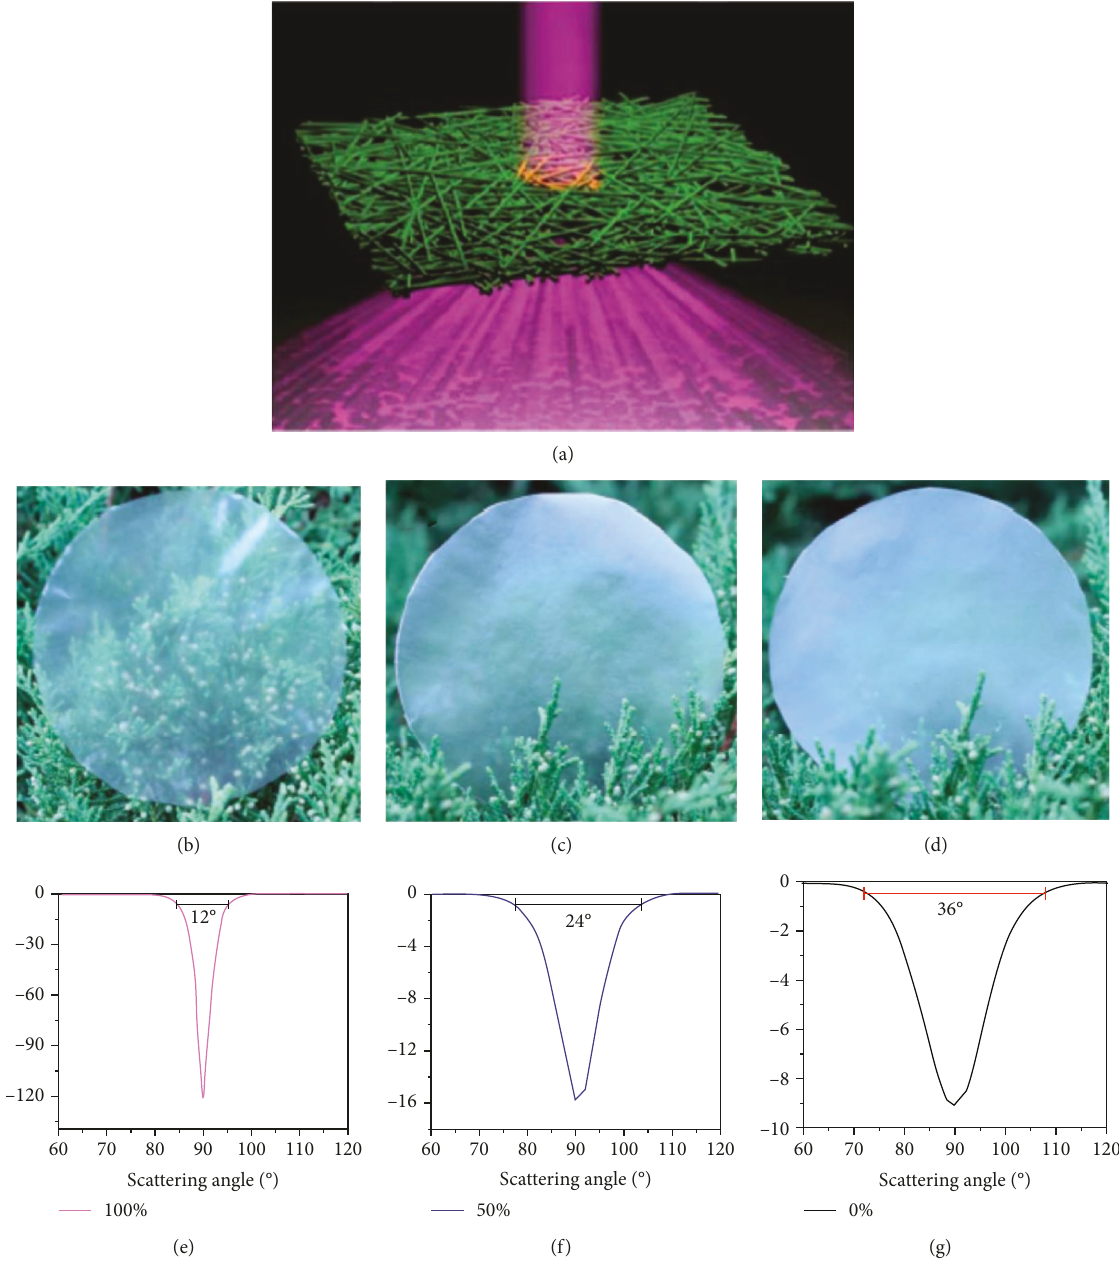
Figure 2: (a) Schematic representation of nanocellulose paper and haze e ff ect. Reproduced from reference [21] with permission from the Royal Society of Chemistry. Visual appearances of the transparent papers with CNF contents of (b) 100%, (c) 50%, and (d) 0%, respectively. Distribution of the scattering angle and maximum scattering angle for the transparent papers (b – d) with a di ff erent ratio of CNFs to the whole cellulose content: (e) 100%, (f) 50%, and (g) 0% CNFs. Reproduced from reference [20] with permission from the Royal Society of